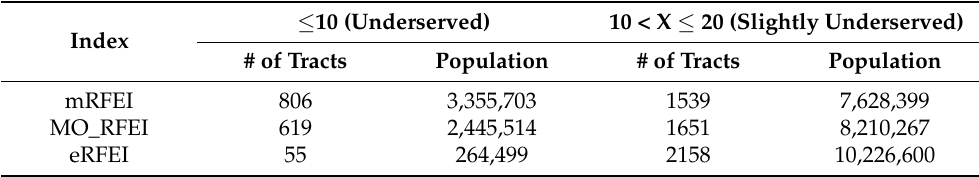
Table 1. Statistical comparison of the three food environment indices in Florida.